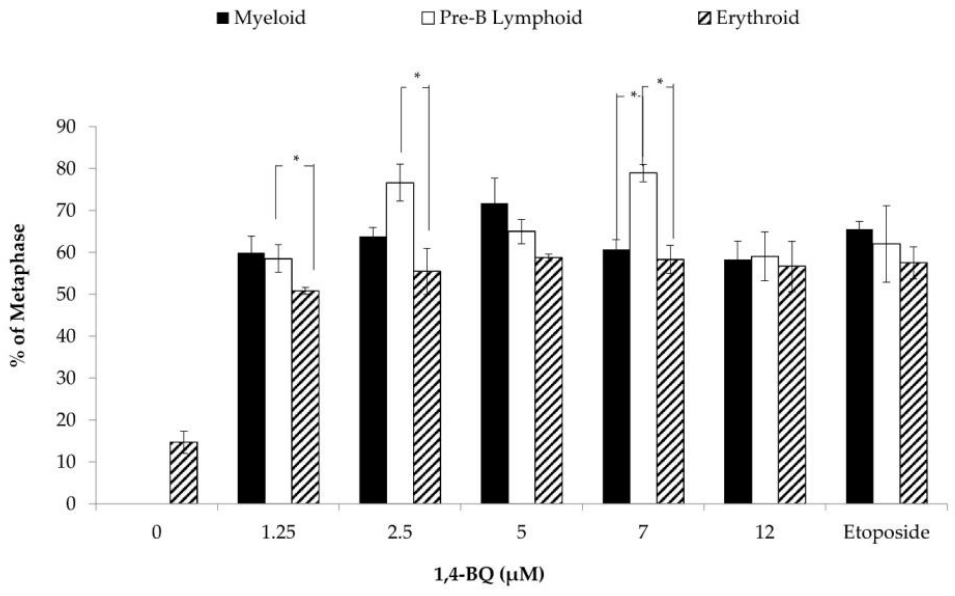
Figure 11. CA in different lineages of hematopoietic progenitors harvested after CFU assay following pre-exposure of MBMCs to 1,4-BQ treatment for 24 h. Twenty metaphases were scored for each experimental group and the percentage of CA is as presented. Data are presented as the mean ± S.E.M. ( n = 3) and analyzed by using one-way ANOVA. * p < 0.05 compared between the progenitors.